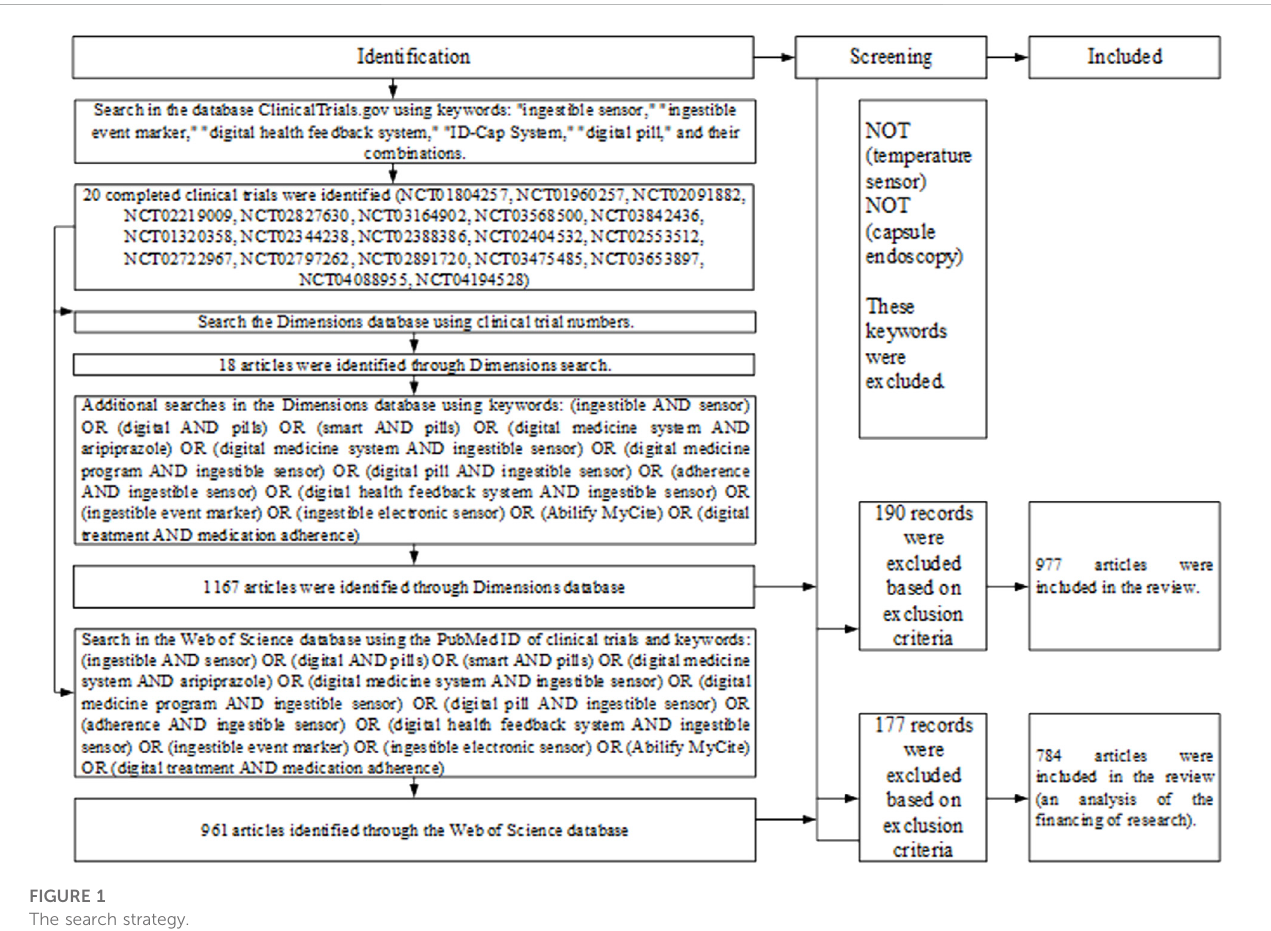
FIGURE 1 The search